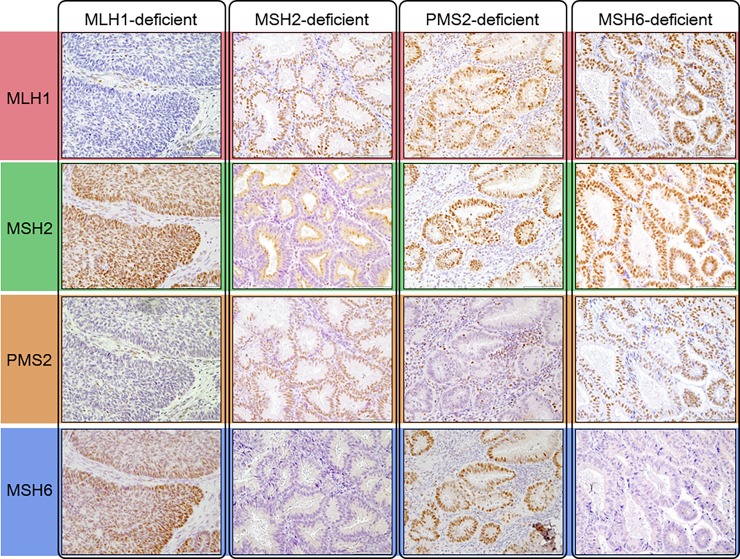
Representative examples of immunohistochemistry staining for the four MMR proteins.Tumors with MLH1-deficiency (dMLH1) show negative expression in both MLH1 and PMS2 IHC, those with MSH2-deficiency (dMSH2) show negative expression in both MSH2 and MSH6 IHC, with PMS2-deficiency (dPMS2) they show negative expression only in PMS2, and tumors with MSH6-deficiency show negative expression only in MSH6.